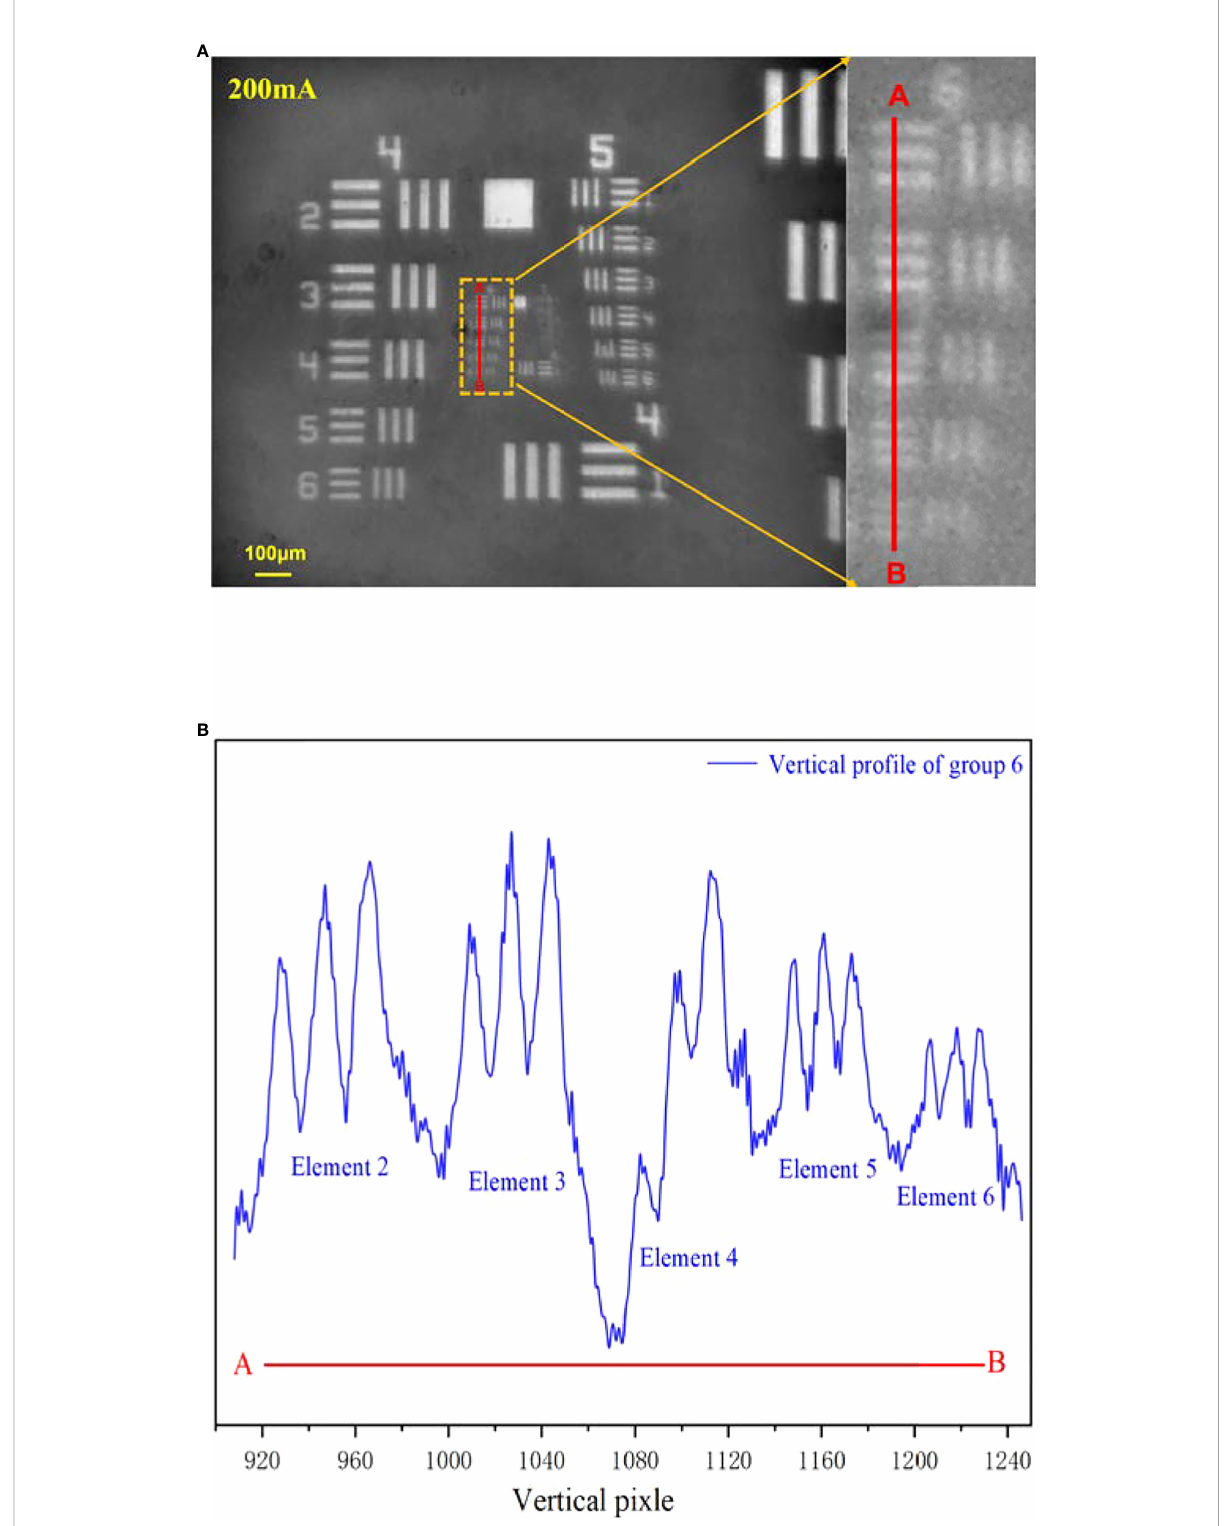
FIGURE 4 The MICROcean imaging resolution at the current of 200 mA. (A) The original image and its enlarge image in the sixth line pairs group. (B) The vertical intensity pro fi le of group